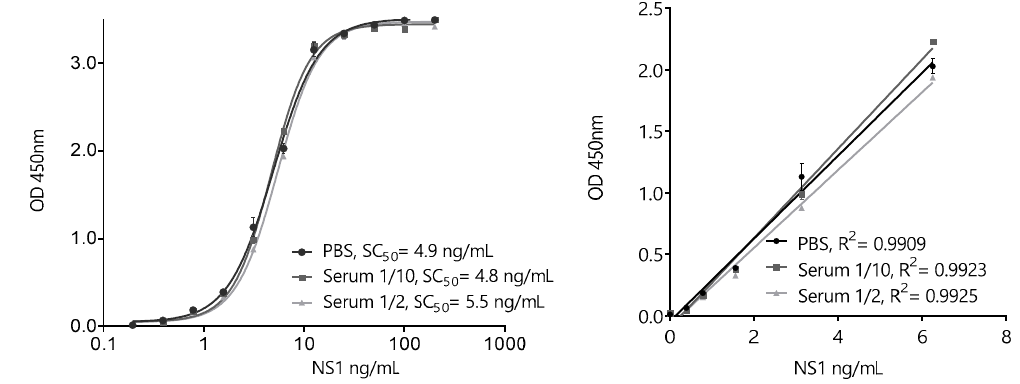
Figure 8. ZVNS1-32 / D6 nanobody sandwich ELISA for the detection of ZVNS1. Extended (left) and linear (right)-range calibration curves performed in phosphate-buffered saline (PBS) or serum dilutions. The results are the average values of triplicate measurements, and the error bars represent the standard deviation.